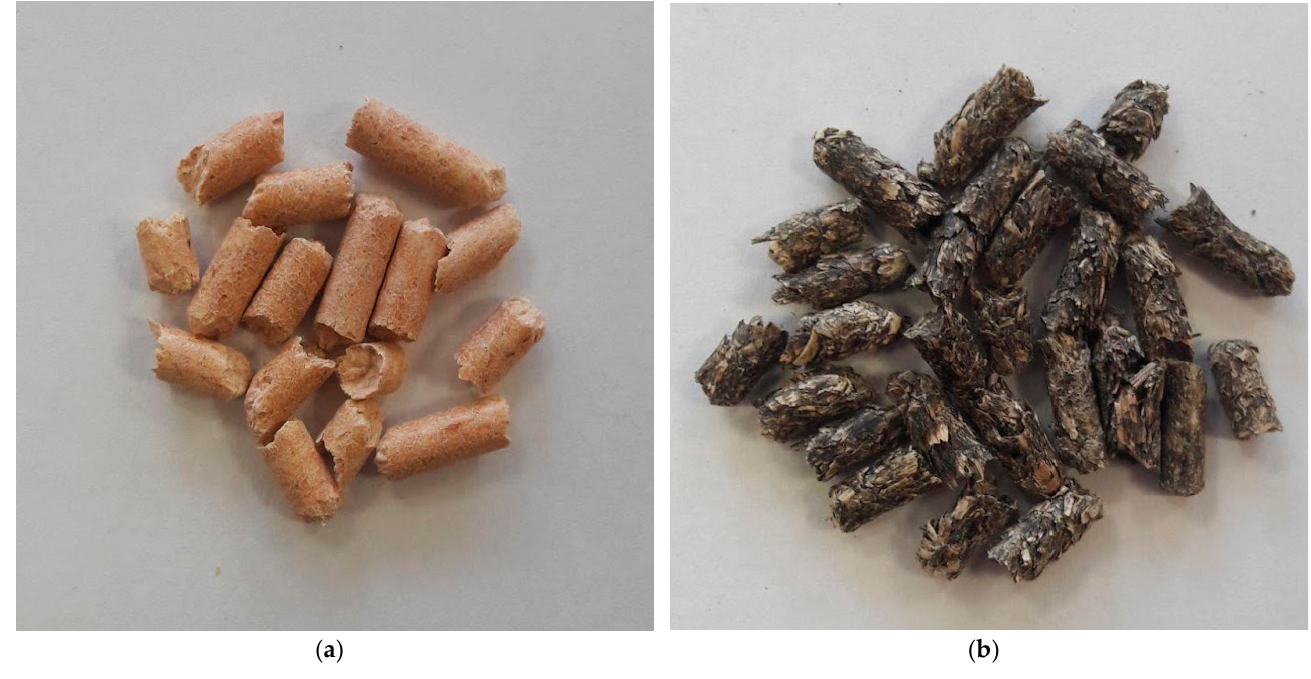
Figure 1. Tested pellet: ( a ) Pine; ( b ) Hemp.